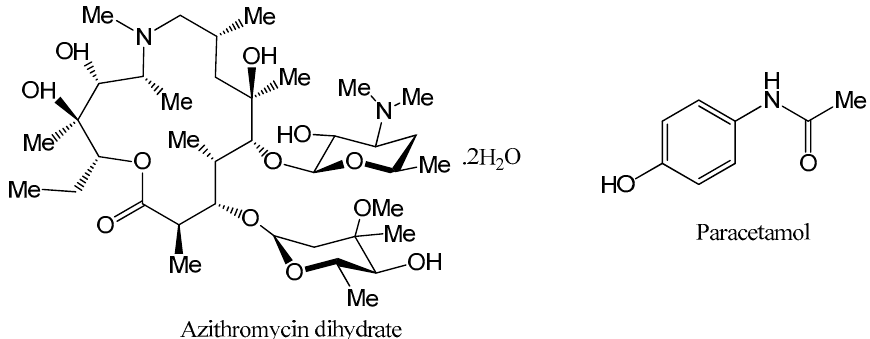
Figure 1. Chemical structures of azithromycin dihydrate (AZT DH) and paracetamol (PCM).